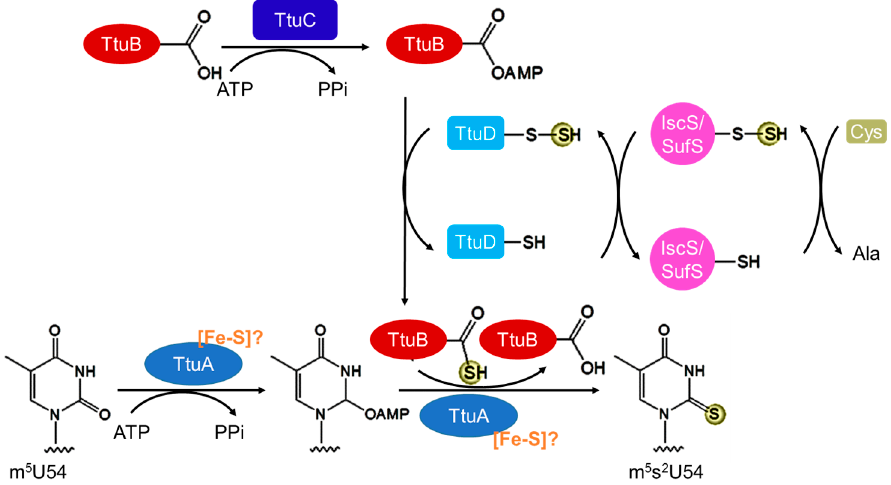
Figure 5. The 2-thiolation process of tRNA U54 in the thermophilic bacterium T. thermophilus Figure 5. The 2 ‐ thiolation process of tRNA U54 in the thermophilic bacterium T. thermophilus .